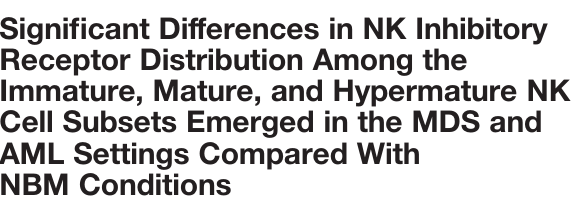
FIGURE 4 | Ratio of cell percentages in distinct NK maturation subsets within the bone marrow microenvironment of NBM, MDS, and AML cases. (A) Ratio of cell percentages for the indicated NK maturation subsets (mature to immature, hypermature to immature, and hypermature to mature) in normal bone marrow (NBM, n = 30) cases. Data are presented as scatter dot plots, and the lines represent the mean ± SEM (****P < 0.0001, ns, not signi fi cant; Wilcoxon signed rank test). (B) Ratio of cell percentages for the indicated NK maturation subsets (mature to immature, hypermature to immature, and hypermature to mature) in myelodysplastic syndromes (MDS, n = 25) cases. Data are presented as scatter dot plots, and the lines represent the mean ± SEM (****P < 0.0001, ns, not signi fi cant; Wilcoxon signed rank test). (C) Ratio of cell percentages for the indicated NK maturation subsets (mature to immature, hypermature to immature, and hypermature to mature) in acute myeloid leukemia (AML, n = 8) cases. Data are presented as scatter dot plots, and the lines represent the mean ± SEM (*P < 0.05, ns, not signi fi cant; Wilcoxon signed rank